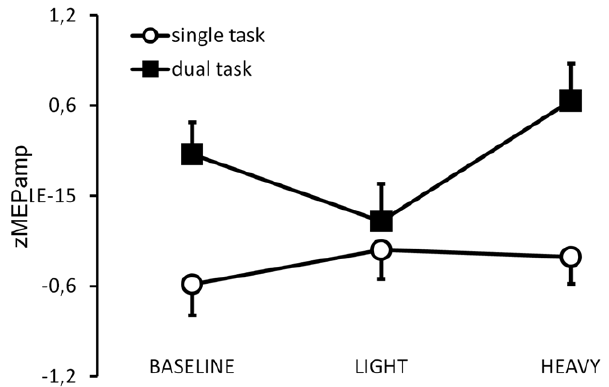
Figure 3. Interaction effect of the observed weight and the visual discrimination task on MEP values of the OP in experiment 2. z transformed MEP amplitudes (zMEPamp) are shown for the single task (open circles) compared with the dual task (black squares) for the three different observation conditions. Vertical bars indicate standard